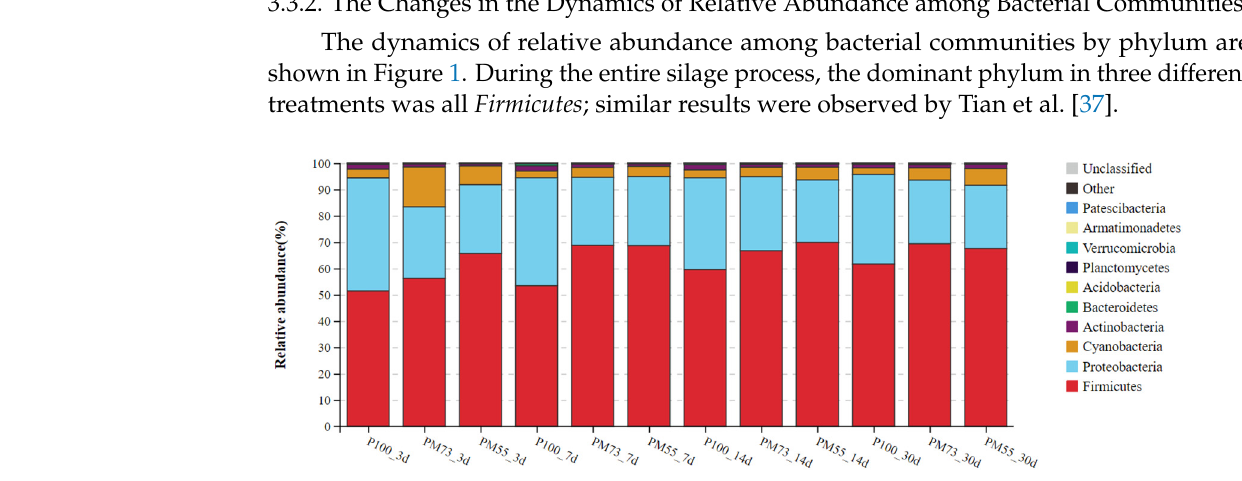
Figure 1. Bacterial community and relative abundance by phylum for mulberry leaf silages (P100,